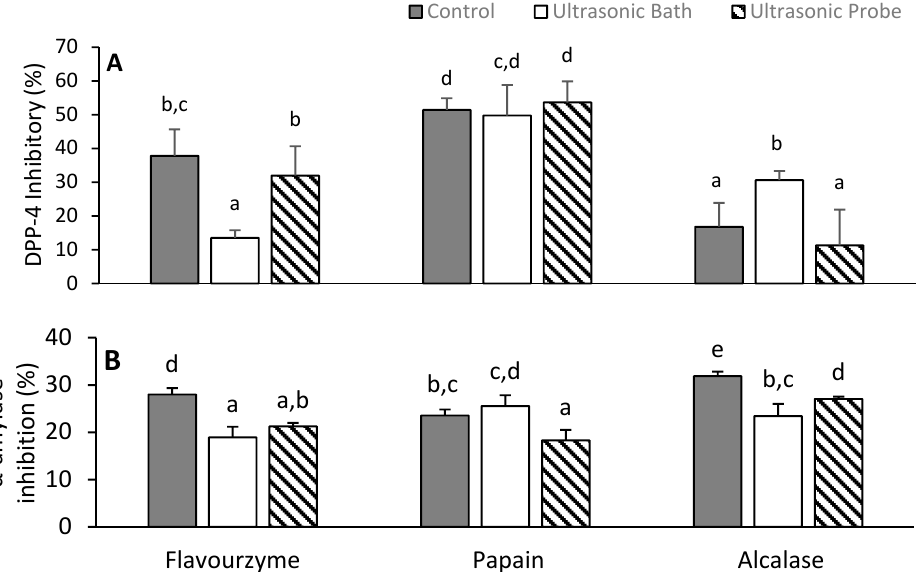
Figure 4. ( A ) Dipeptidyl peptidase-4 (DPP-4) and ( B ) α -Amylase inhibition by protein hydrolysates at 1 mg/mL and 1.25 mg/mL, respectively. Data are expressed as the mean of triplicates ± the standard deviation. The letters above each bar represent significant differences as determined with a least significant difference (LSD) in a one-way ANOVA ( p -value < 0.05).